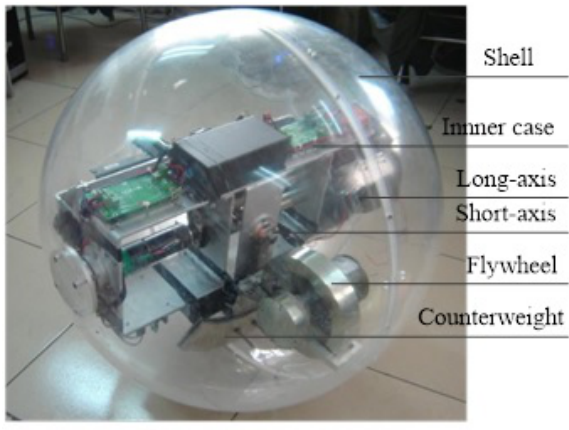
Fig. 1 Motion mode of the robot.